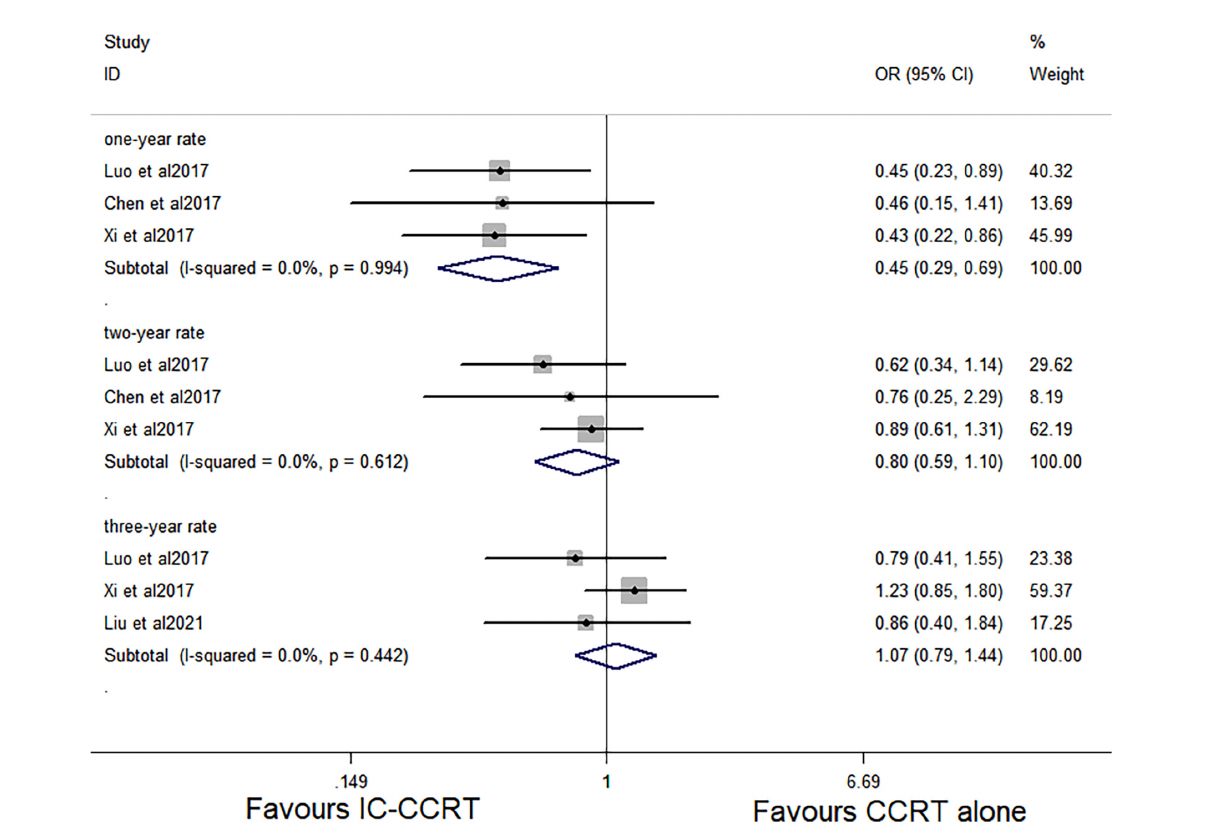
FIGURE 2 | Effects of IC-CCRT vs . CCRT alone on 1-, 2-, and 3-year OS. IC-CCRT, induction chemotherapy followed by concurrent chemoradiotherapy; CCRT, concurrent chemoradiotherapy; OS, overall survival; CI, con fi dence interval; ES, effect